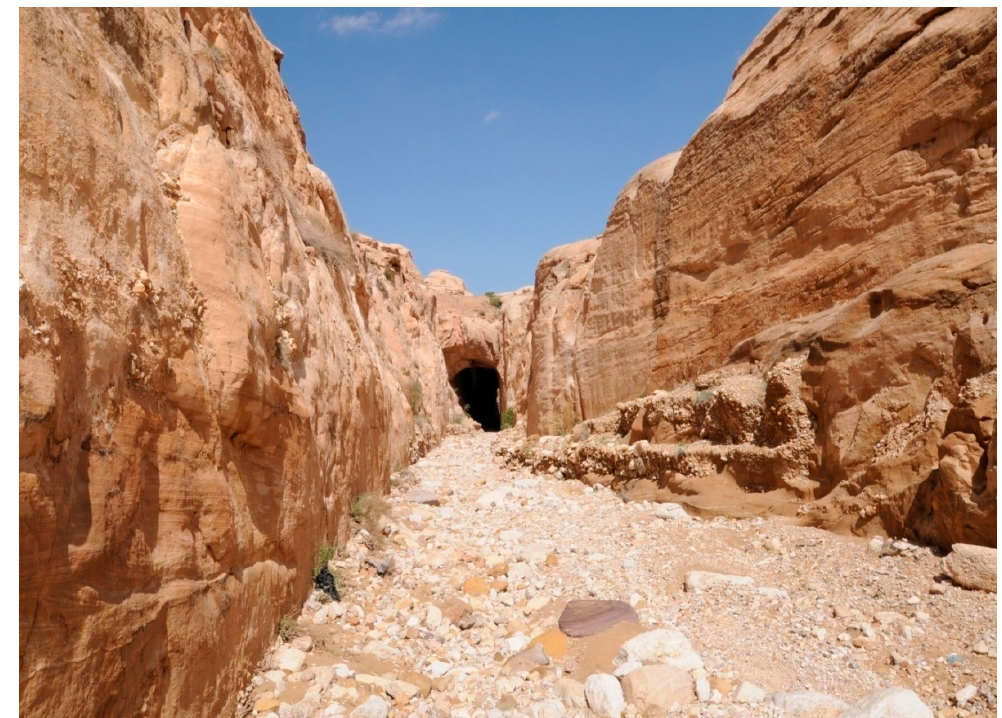
Figure 3. Nabataean drainage tunnel leading water away from the Siq entry to the Wadi Sayagh through channels extending from and parallel to the Wadi Mataha streambed (Figure 1, solid line path through 2-D, 3-C, 2-C sectors).